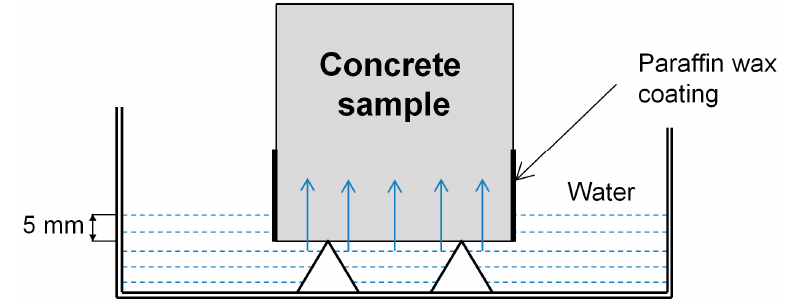
Figure 4. Schematic set-up for measuring the rate of water absorption in concrete specimens.